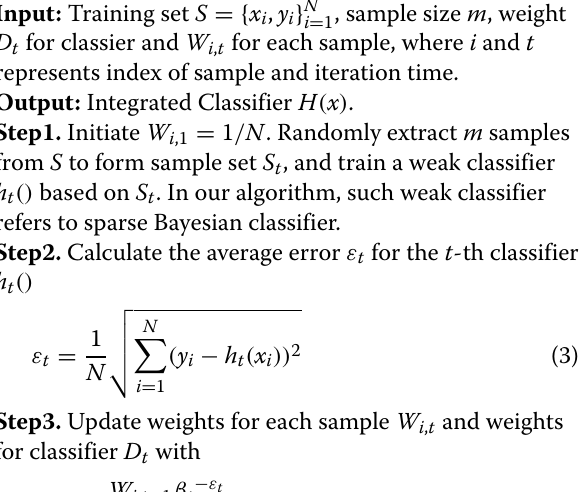
Algorithm 2 AdaBoost strategy with active learning to improve performance of flood